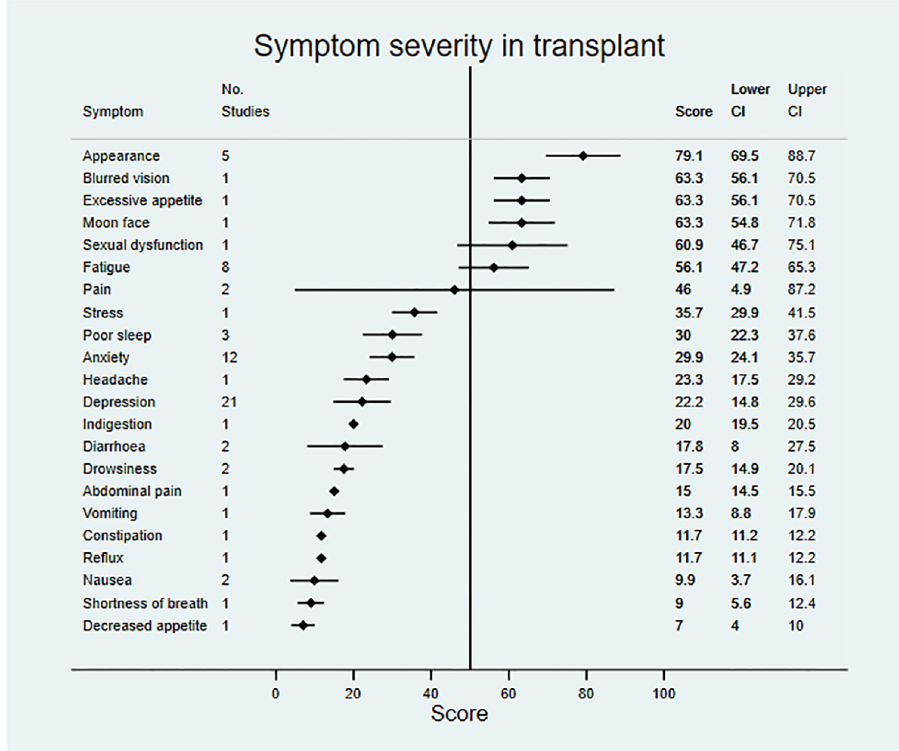
Fig 7. Pooled symptom severity across included studies for patients in receipt of a kidney transplant. Scores represent mean severity scores converted to a 0–100 scale, where a higher score indicates greater severity; vertical line at 50 for